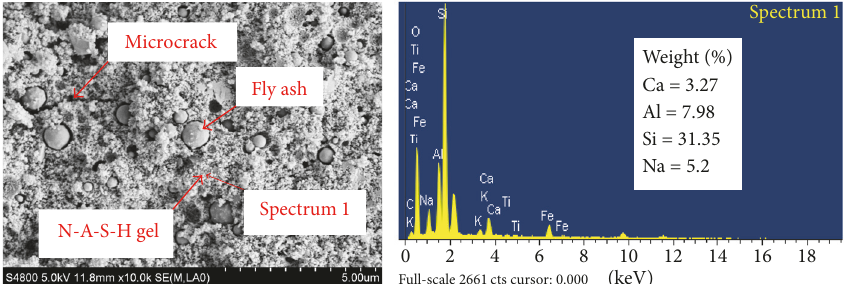
Figure 14: SEM and EDS results of FAGC in the 60-day standard curing group.